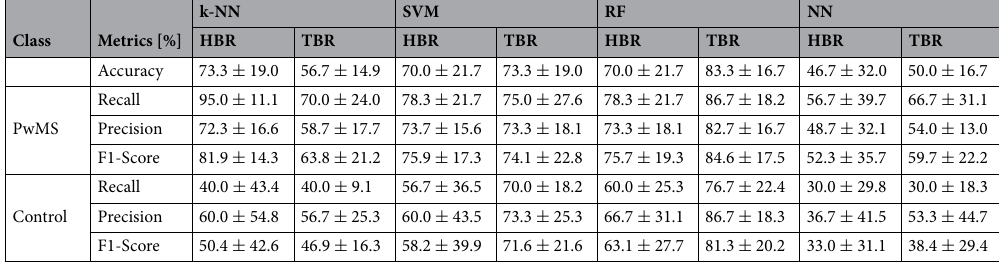
Table 3. Average performance over the 5 test folds of the other ML models in terms of accuracy, recall, precision, and F1-Score per class, for different sets of features (only HBR features or only TBR features).